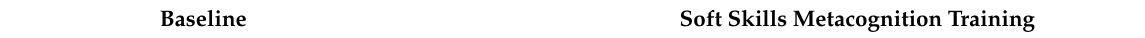
Table 2. Sequences for each experimental condition and respective